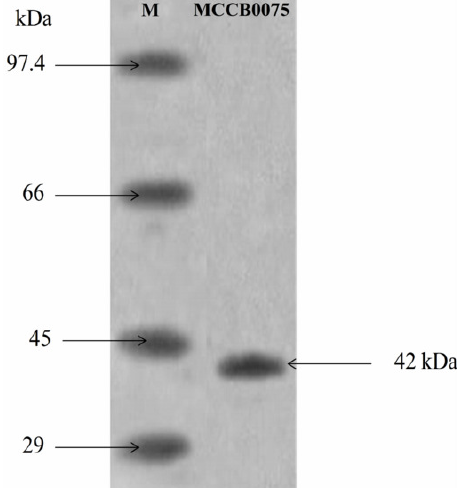
Fig. 3. SDS-PAGE analysis of purified amylase of